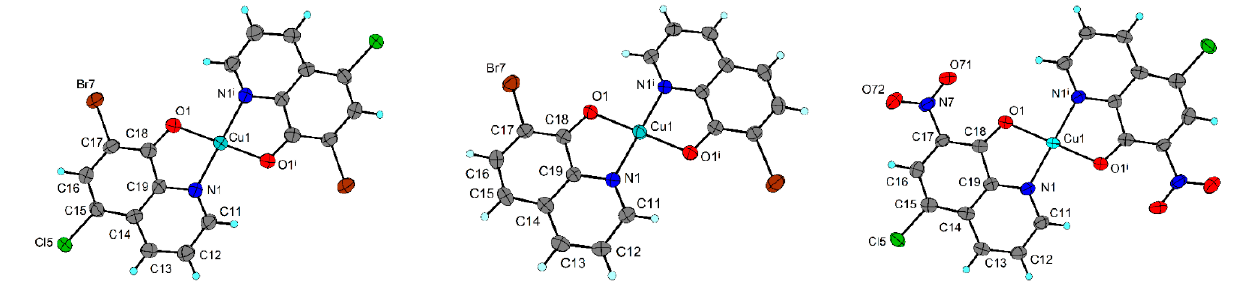
Table 1. Selected bond lengths [Å] and angles [°] for 1a , 1b , 3 and 6 .